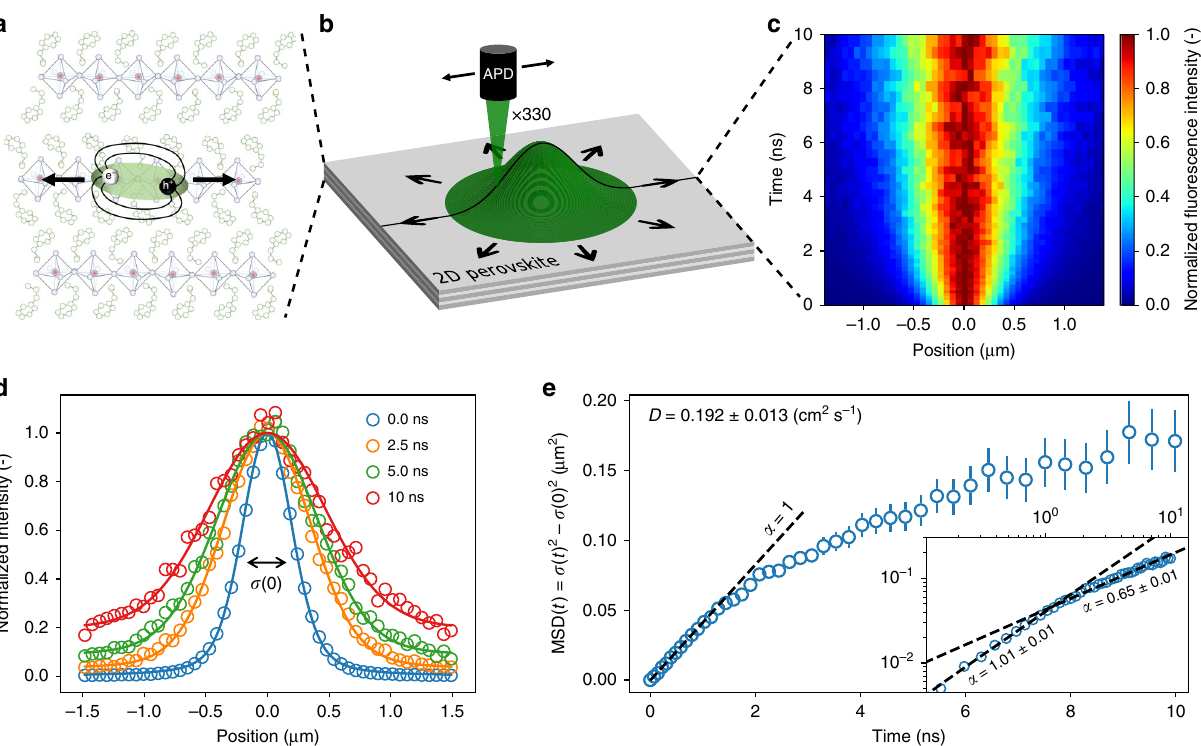
Fig. 1 Diffusion imaging of excitons in two-dimensional perovskites. a Illustration of the (PEA) 2 PbI 4 crystal structure, showing the perovskite octahedra sandwiched between the organic spacer molecules. b Schematic of the experimental setup. A near-diffraction limited exciton population is generated with a pulsed laser diode. The spatial and temporal evolution of the exciton population is recorded by scanning an avalanche photodiode through the magni fi ed image of the fl uorescence I( x , t ). c Fluorescence emission intensity I( x , t ) normalized at each point in time to highlight the spreading of the excitons. d Cross section of I( x , t ) for different times t c . e Mean-square-displacement of the exciton population over time. Two distinct regimes are present: First, normal diffusion with α = 1 is observed, which is followed by a subdiffusive regime with α < 1. The inset shows a log – log plot of the same data, highlighting the two distinct regimes. Reported errors represent the uncertainty in the fi tting procedure for σ ( t ) 2